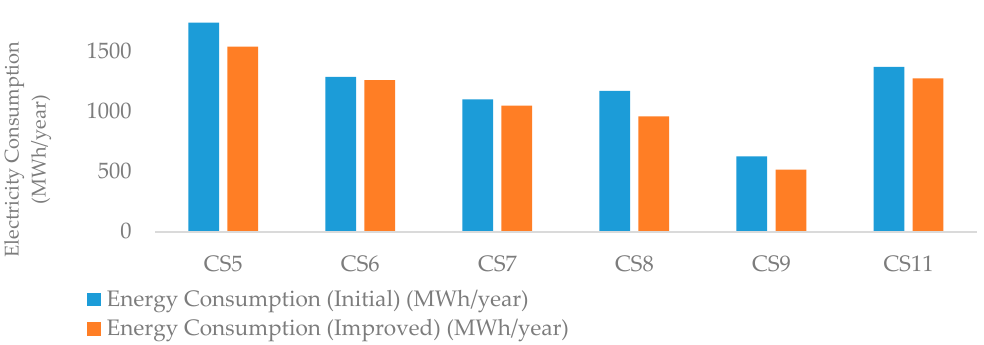
Figure 6. Electricity consumption for the initial and improved operation of the IWC (Average consumption cases).